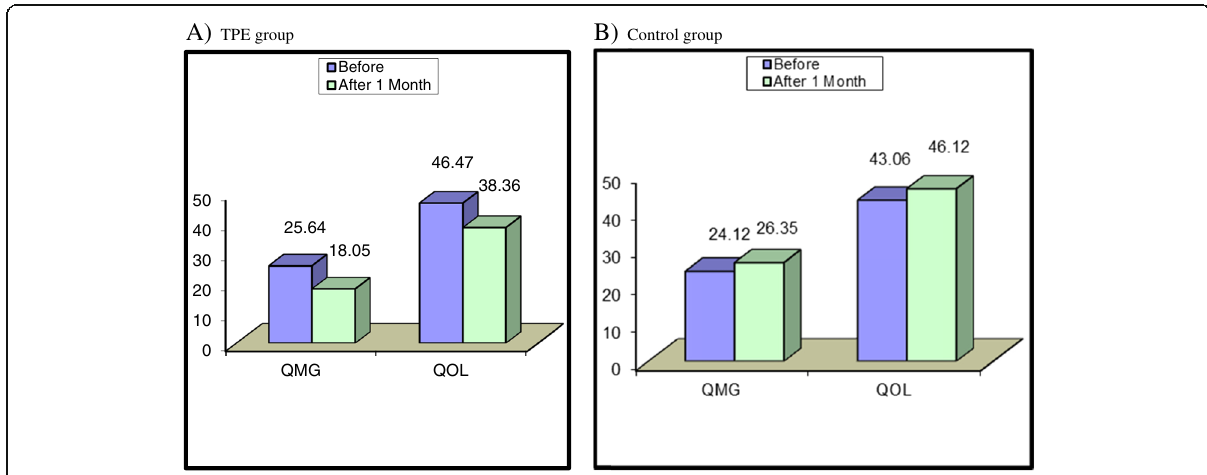
Fig. 1 QMG and QOL scores at initial after 1 month in TPE and control groups